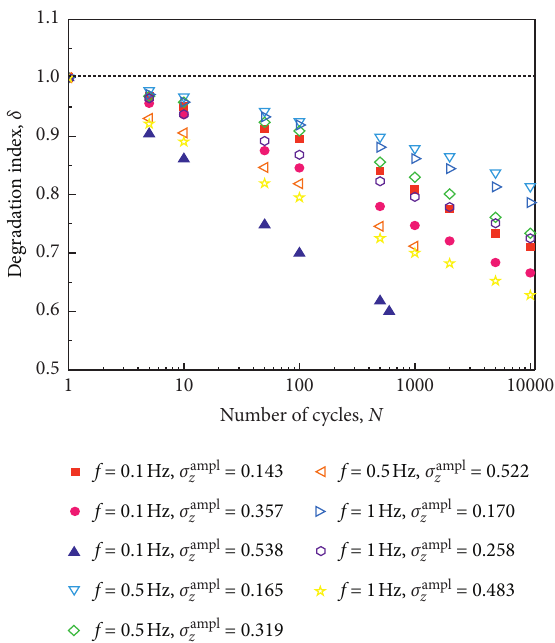
Figure 6: Influence of cyclic stress ratio on the development law of degradation index.